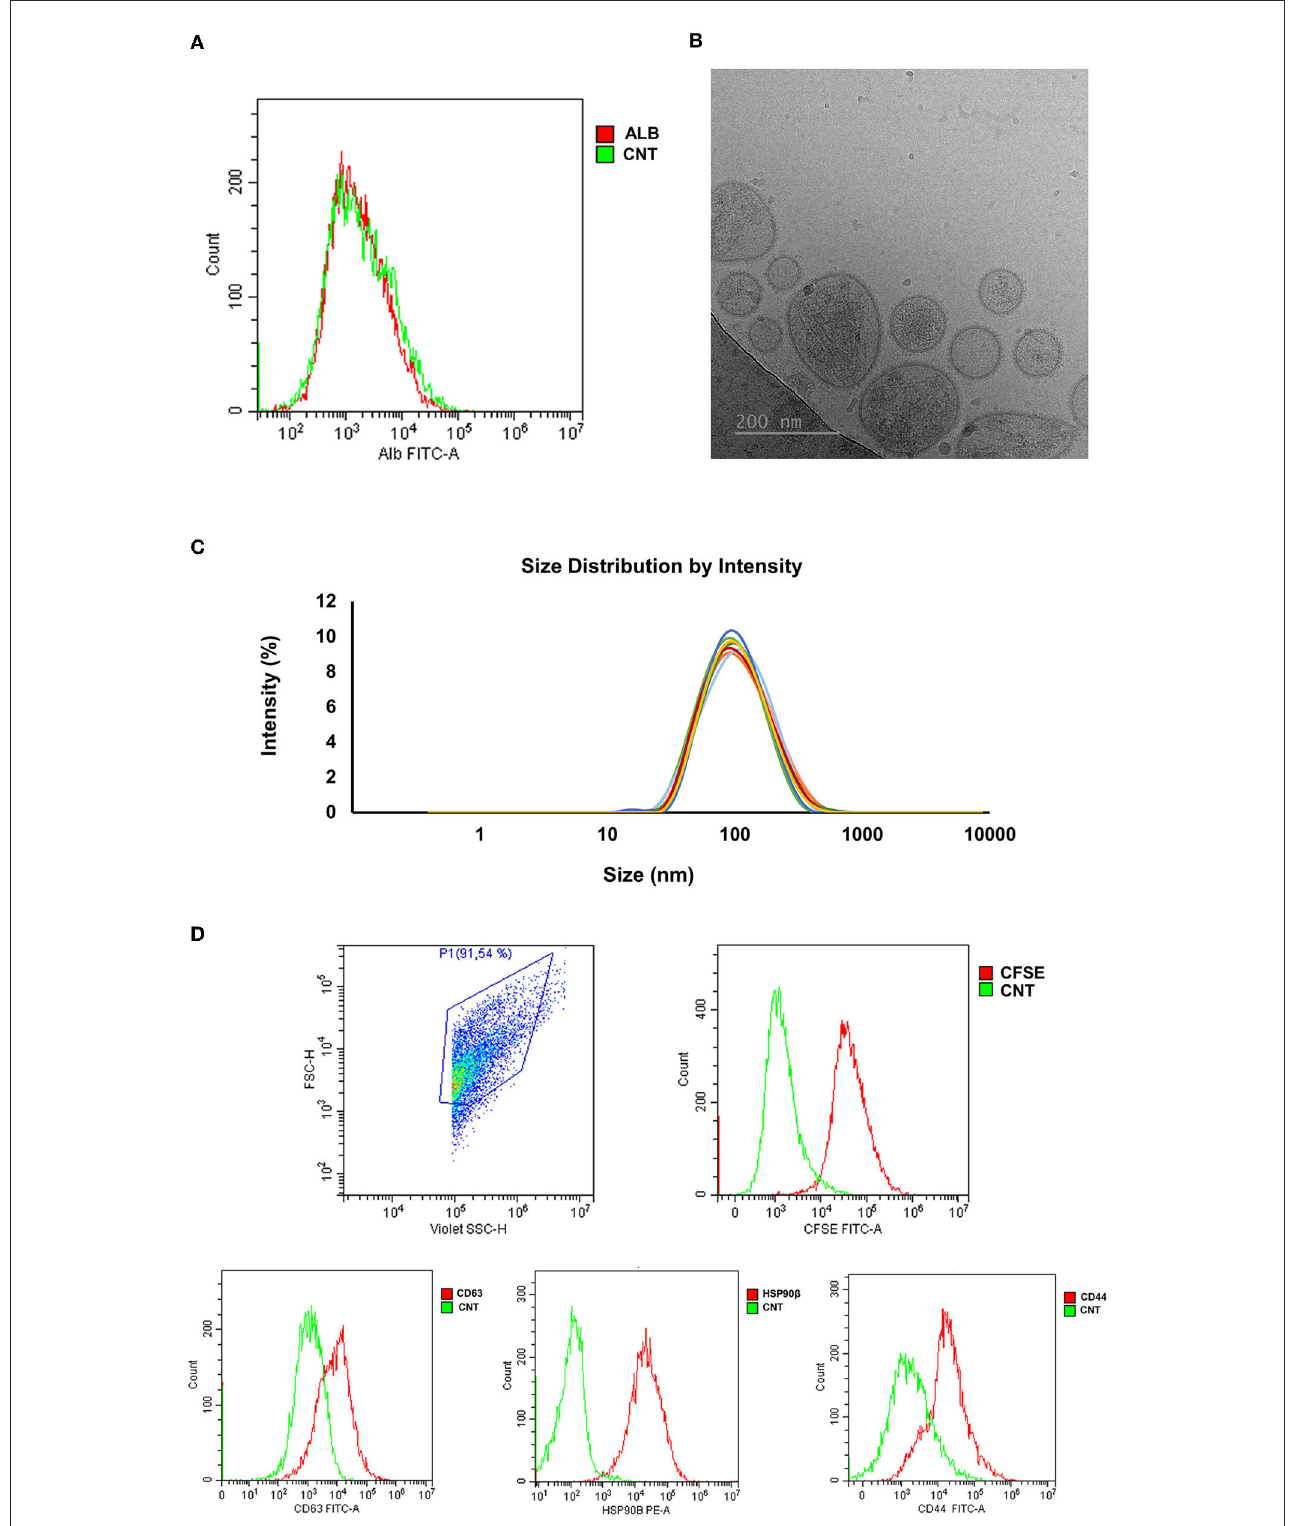
FIGURE7 Characterization of seminal extracellular vesicles (sEVs) isolated from pig seminal plasma (SP) ( n = 8; each sample pooled 10 individual SP samples) by serial centrifugations, size exclusion chromatography and ultrafiltration. (A) Representative histogram of albumin (ALB) assessed in EV-samples by flow cytometry. (B) Representative image of sEVs assessed by cryo-electron microscopy. (C) Particle size distribution of sEVs assessed by dynamic light scattering. Each lines represent the intensity size distribution in each EV-sample. (D) Representative histograms of CFSE/CD63/HSP90 β /CD44 expression in seminal EVs assessed by flow cytometry. CFSE, Carboxyfluorescein succinimidyl ester; HSP90 β , Heat Shock Protein 90 β ; CNT,